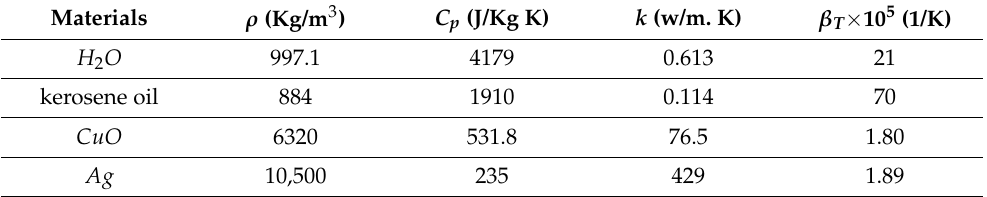
Table 1. The numerical values for water, kerosene oil, copper oxide, and silver nanoparticles.